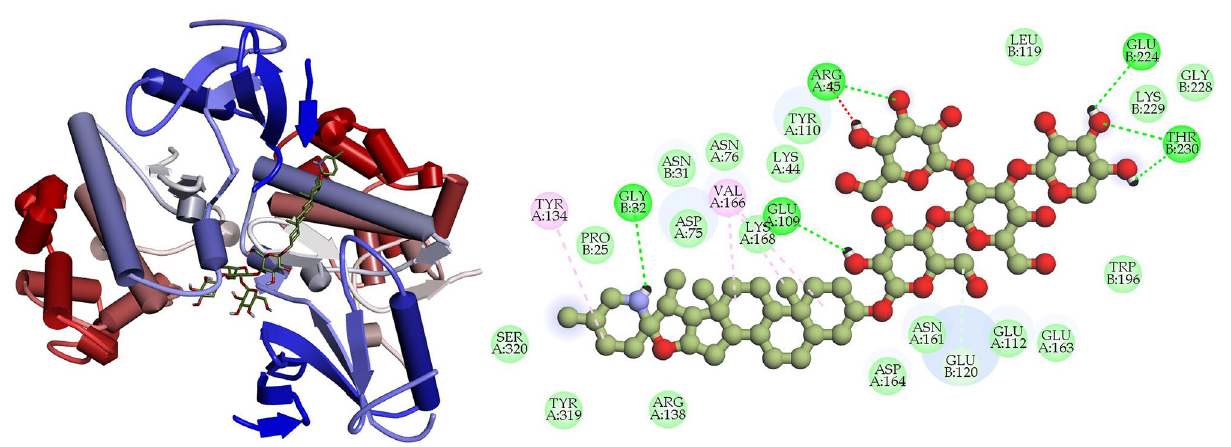
Figure 7. Depicted the interaction between the compound CID: 28523 (Tomatine) and MAPK6. Left side representing 3D and the right side representing 2D complex protein–ligand